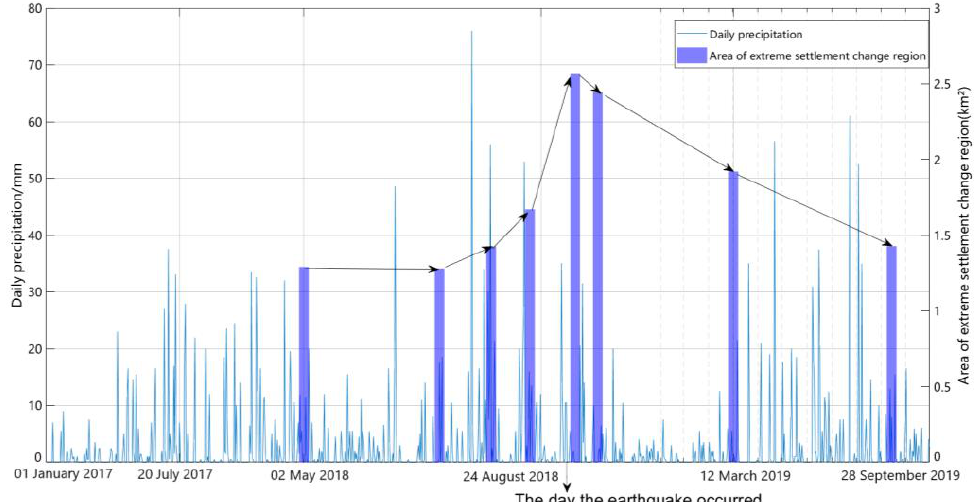
Figure 14. Daily precipitation and strong subsidence area during the study period. Source: Japan Meteorological Agency.